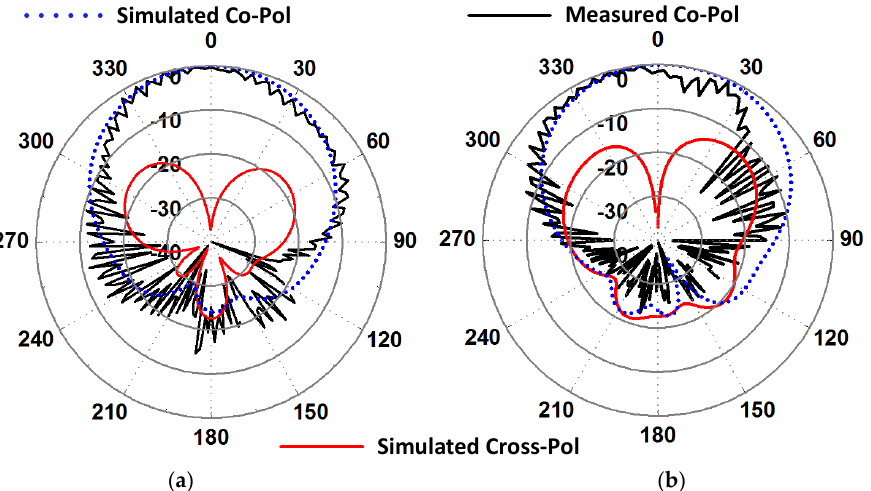
Figure 8. Normalized measured (at 33.35 GHz) and simulated (at 34 GHz) radiation pattern of the designed antenna; ( a ) in E-plane, ( b ) in H-plane. Table 2. Comparison with previously reported cp antenna